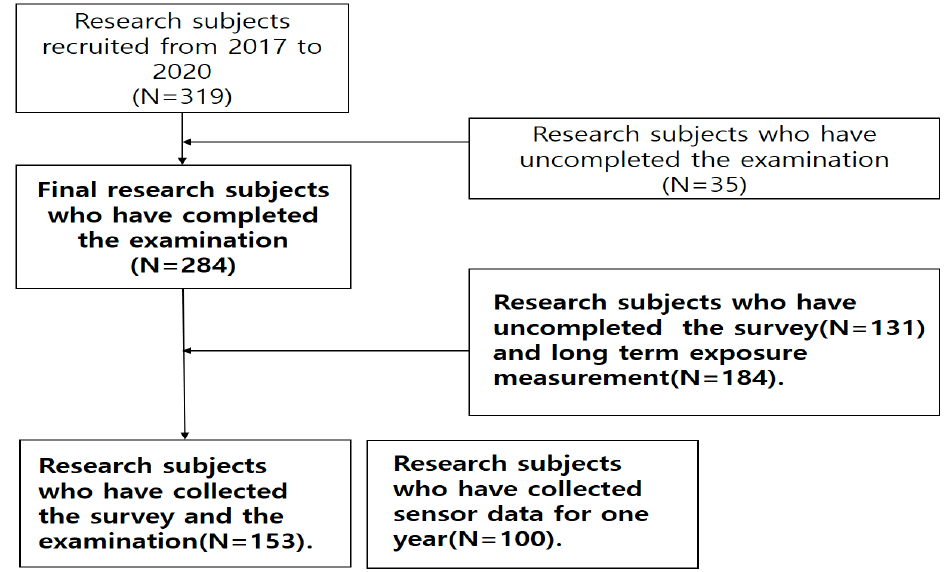
Figure 1. Flow chart of the study population .